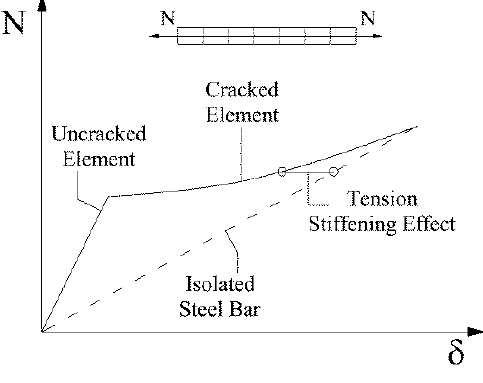
Figure 1 . Effects of the tension stiffening on an isolated reinforcing bar. Figure 1. Effects of the tension stiffening on an isolated reinforcing